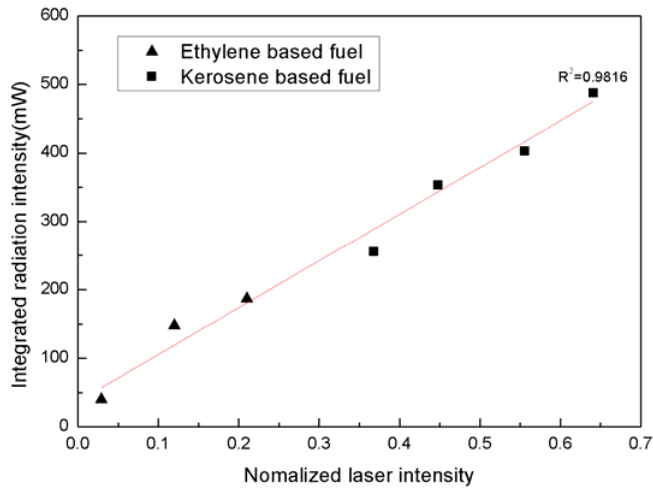
Figure 13. Relationship between radiation intensity and soot emission over all previous data measured from both kerosene and ethylene based ‐ flames.